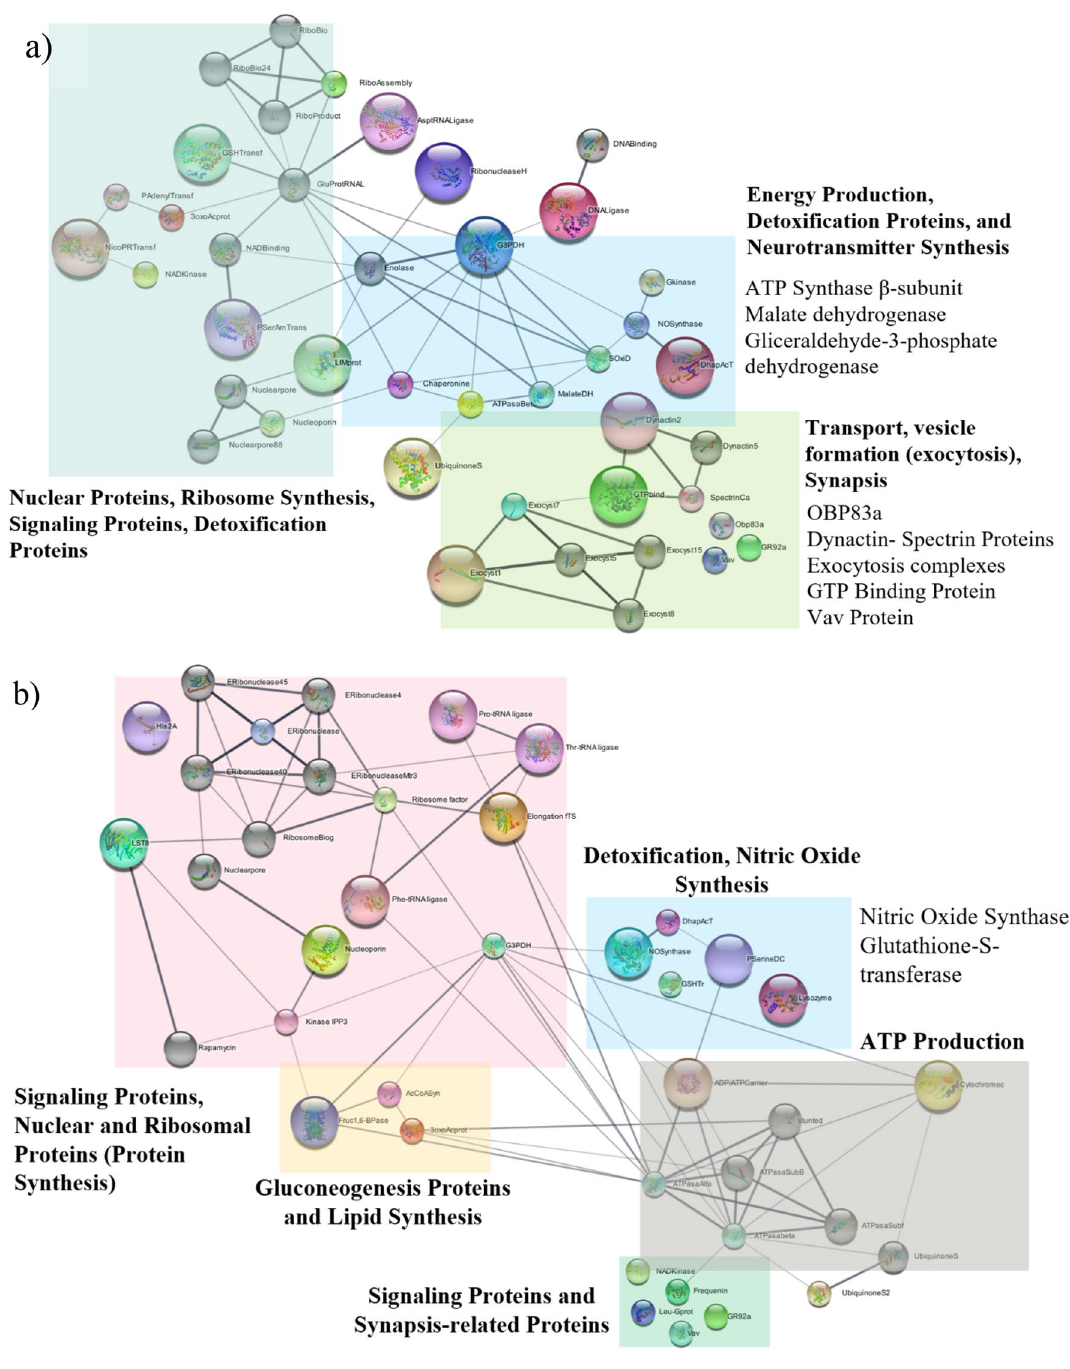
Figure 7. Interactomes obtained by STRING software considering the identified proteins. Reference organism: Drosophila melanogaster. Protein–protein interactions obtained for ( a ) mixture 1 (geranyl acetate, α-bisabolol, and nerolidol) at 100 mg/mL, and ( b ) DEET at 100 mg/mL. The biggest spheres represent over-expressed proteins, the smaller spheres symbolize down-regulated proteins, and gray color spheres represent proteins added by STRING software to find more interactions between protein